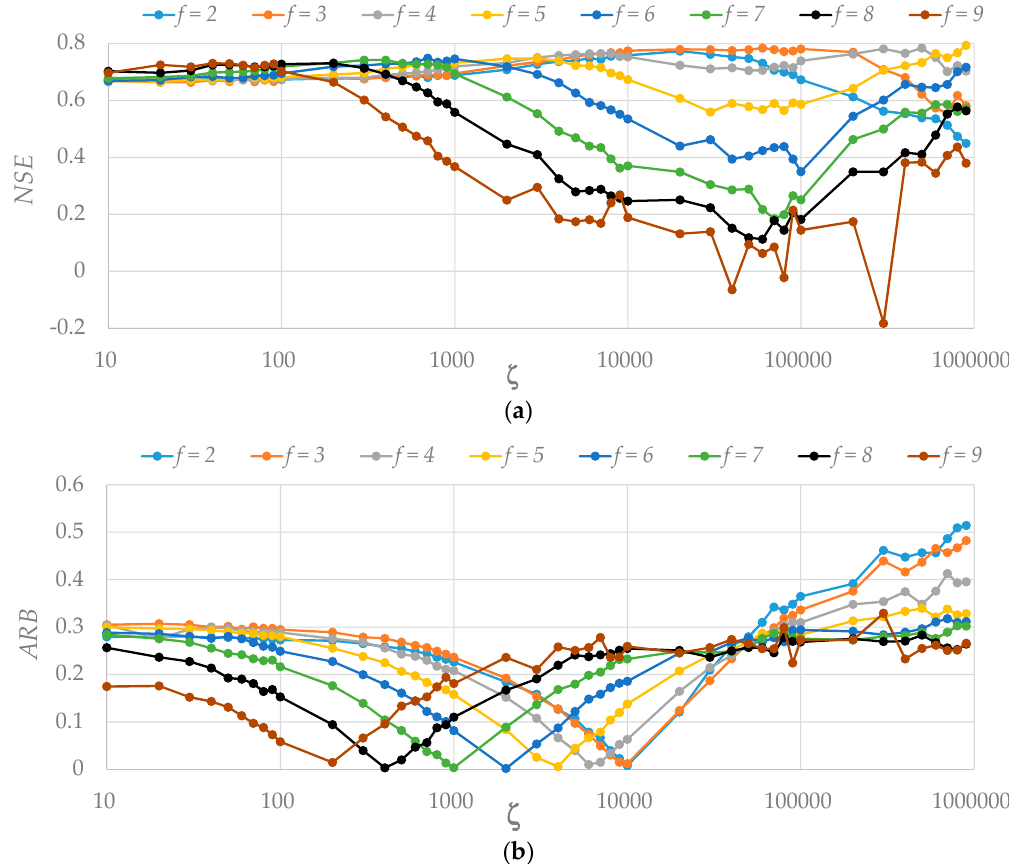
Figure 7. Comparison of the model performance evaluation results for assessing the goodness of fit by ( a ) the Nash–Sutcliffe efficiency ( NSE ); and ( b ) the absolute value of the relative bias ( ARB ) with respect to the hydraulic conductivity decay factor f and the hydraulic conductivity anisotropic ratio ζ in the new CoLM+LF for total runoff during 2009 at the Jindong stream gauge station in the study watershed.